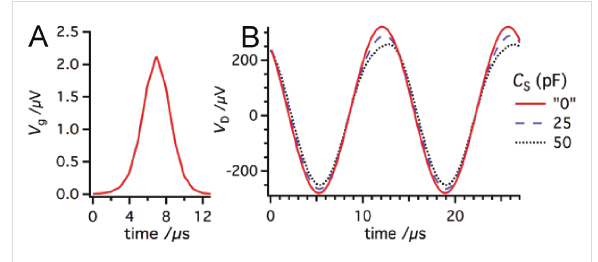
Figure 5: (A) If the slow Op111 is replaced by a faster OPA, Op637, the modulation of the virtual ground can be significantly reduced (by a factor of 40). (B) Consequently, the signal in the deflection channel is altered at much higher C s